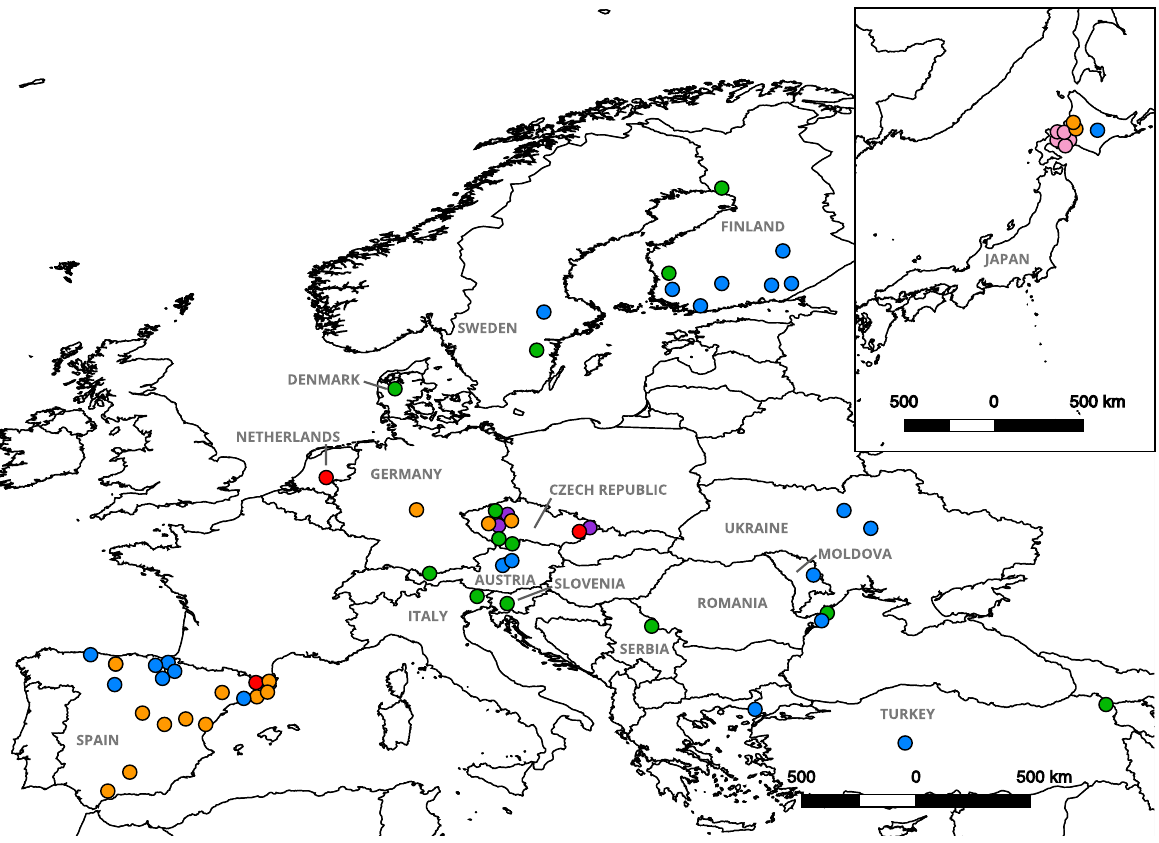
Figure 1. Distribution of Aphanomyces astaci haplotypes detected from locations in Europe and Japan 33,52,53 . Each point and color represent the presence of an A. astaci haplotype based on concatenated mitochondrial rnnS and rnnL regions. Colors indicate the haplotype code at each site as follows: green—a-haplotype, blue—b- haplotype, orange—d1-haplotype, red—d2-haplotype and pink—d3-haplotype [Maps were prepared using QGIS 2.14 (https:// www. qgis. org/ en/